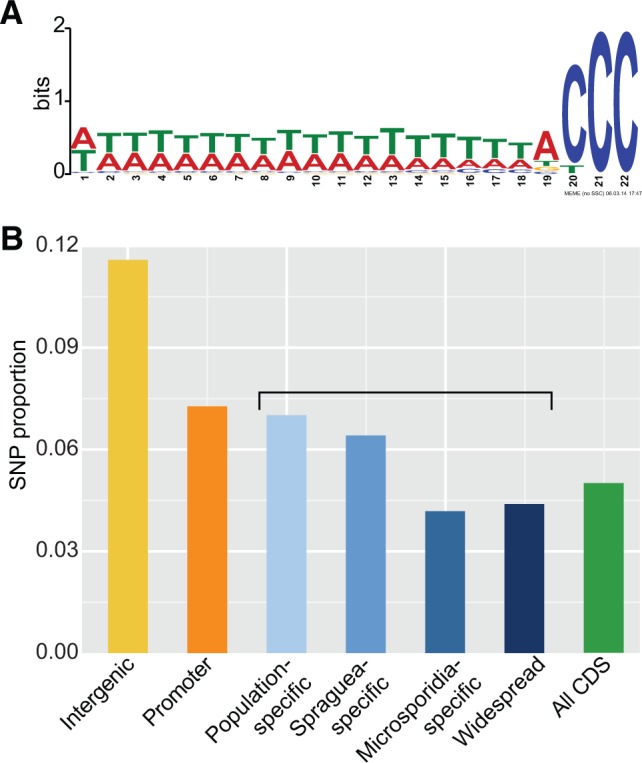
Selective constraint on Spraguea regulatory elements and protein-coding genes. (A) An enriched sequence motif found upstream of 1,439 out of 3,172 genes on the Celtic Deep reference genome. This motif is similar to those described immediately upstream of genes in a number of other Microsporidia, suggesting it may form part of a core microsporidian promoter. (B) Relative selective constraint (frequency of segregating SNPs) across intergenic regions, promoters, and protein-coding sequences on the Celtic Deep genome. Coding sequences are classified according to their taxonomic distribution, from those found only in one Spraguea population (“population-specific”) to those broadly conserved in eukaryotes.